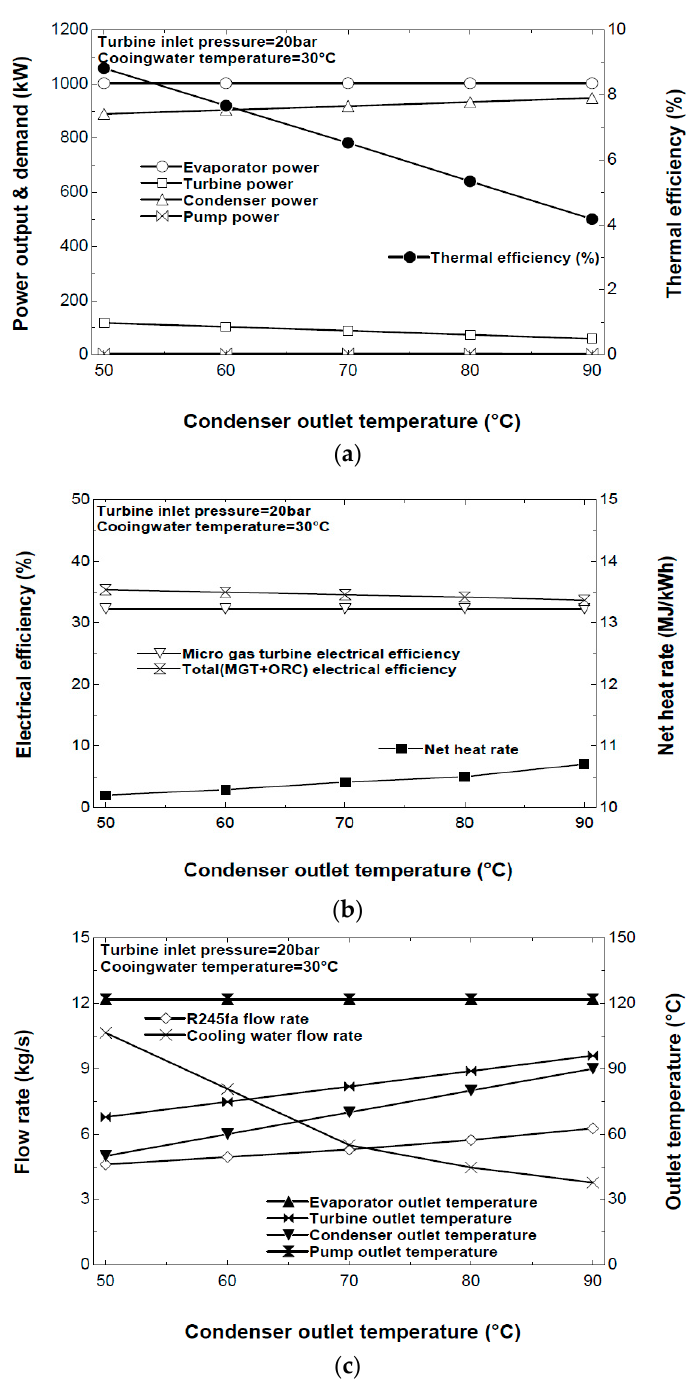
Figure 6. Effect of the condenser outlet temperature of the cooling water on the performance and operating conditions of the organic Rankine cycle. ( a ) The power output and demand for the ORC components and thermal efficiency of the ORC; ( b ) The electrical efficiency of the MGT and the MGT with the ORC. The net heat rate of the MGT with the ORC; ( c ) The mass rate and the outlet temperature for the streams in the